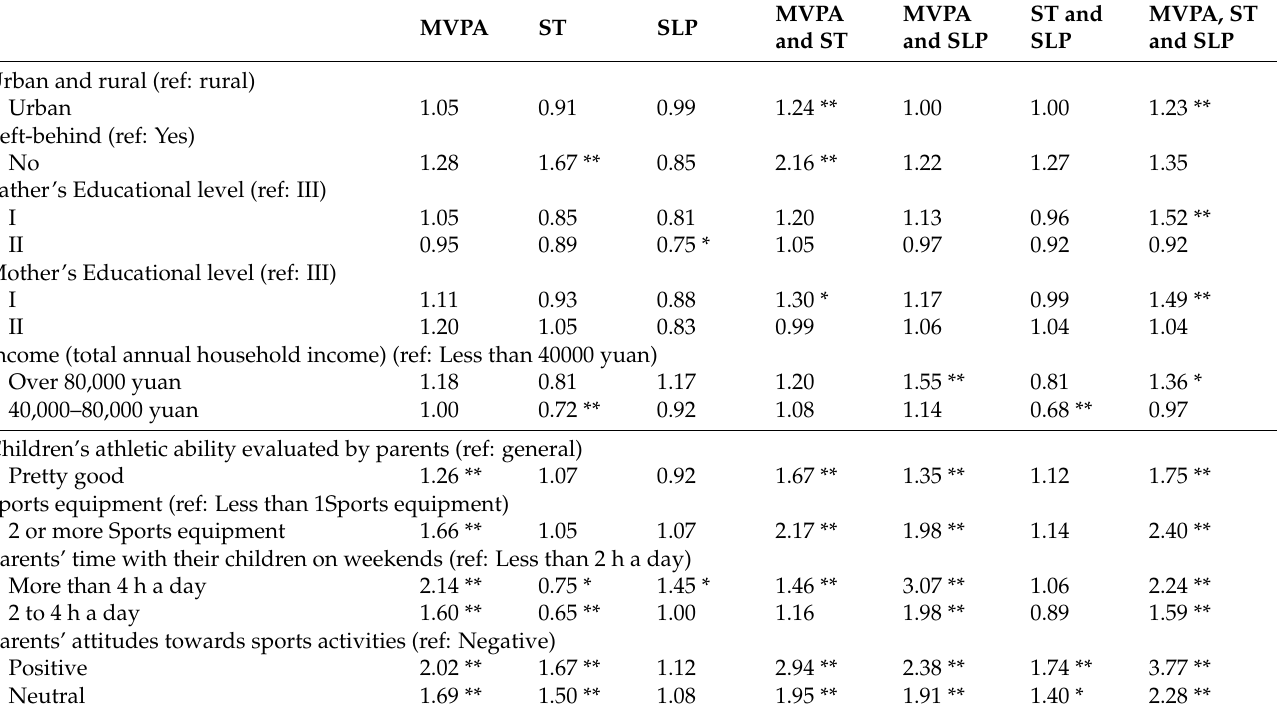
Table A2. The OR values for the 8 combinations of three health-related behaviors. (controlling the children’s sex, age, height and weight